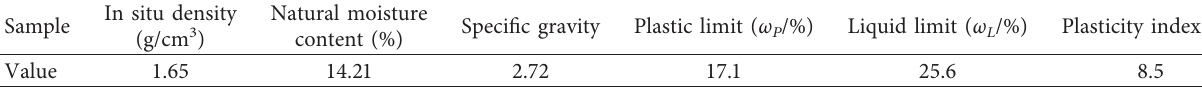
Figure 1: Major occurrence of Loess Plateau in Shaanxi and sampling location at the excavation site. Table 1: Some basic geotechnical properties of the tested material.